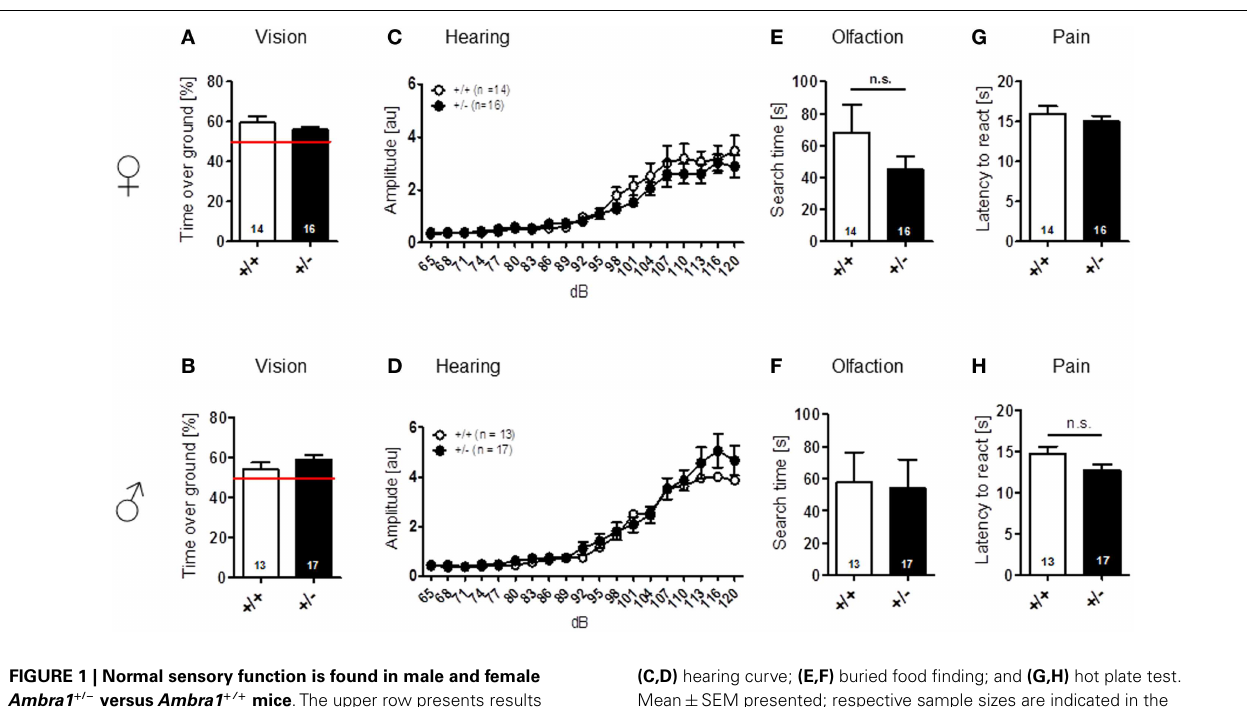
FIGURE 1 | Normal sensory function is found in male and female Ambra1 + / − versus Ambra1 + / + mice .The upper row presents results for female, the lower row for male mice. (A,B) Visual cliff test;